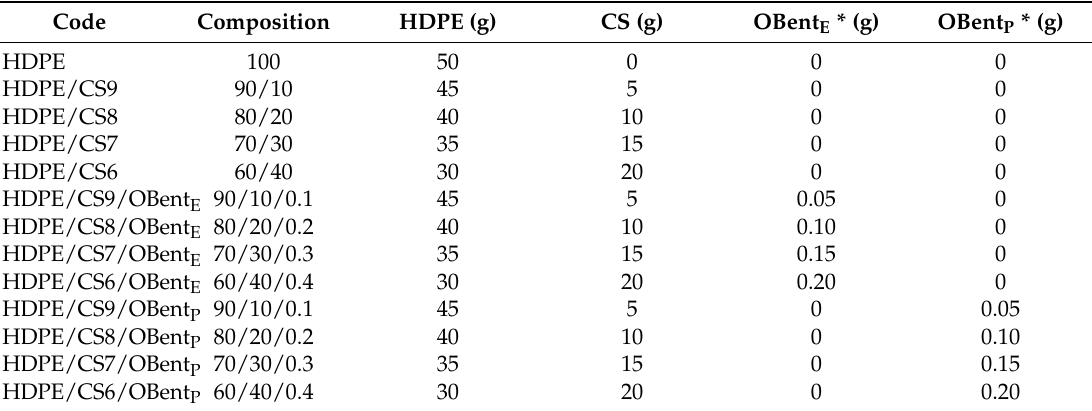
Table 5. Formulation of the prepared